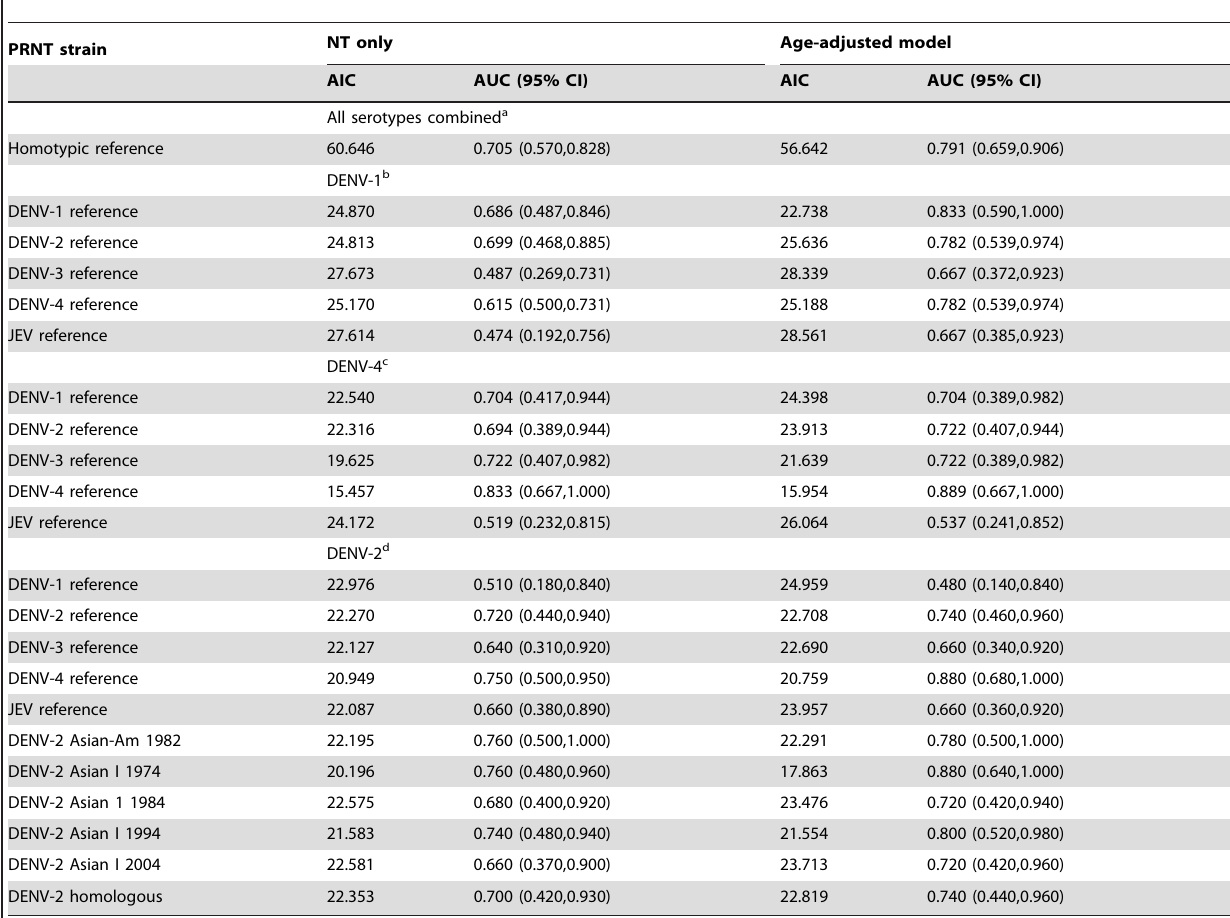
Table 3. Comparison of logistic regression models of neutralizing antibody titers to predict dengue PCR status.